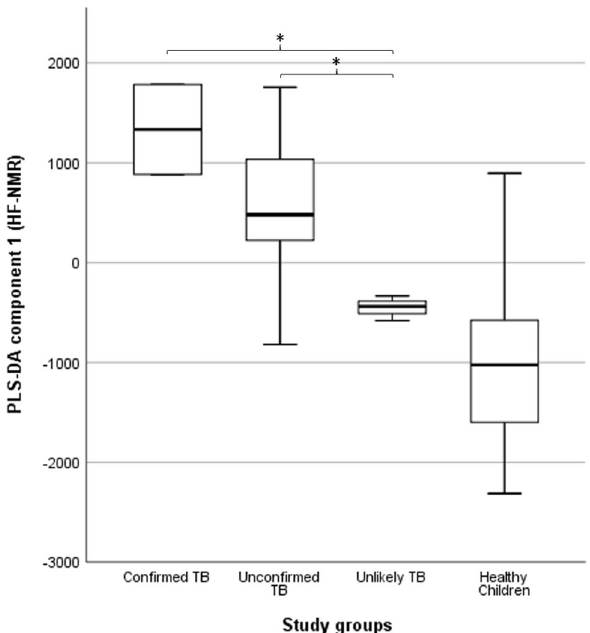
Figure 4. Association between partial least squares discriminant analysis (PLS-DA) scores and study groups in 92 urine spectra of children without TB-treatment acquired by high-field proton (1H) nuclear magnetic resonance. The central horizontal line within the boxes represents the median. The boxes comprise the first and third quartiles, the tiles indicate the maximum and minimum values, and the asterisk indicates statistically significant differences (p-value < 0.05) between groups. TB tuberculosis; PLS-DA 1, the first component of the PLS-DA model. IBM SPSS Statistics 26 (https:// www. ibm. com).